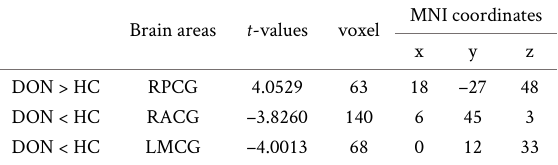
Table 2. Brain areas with significantly different fALFF values between DON patients and